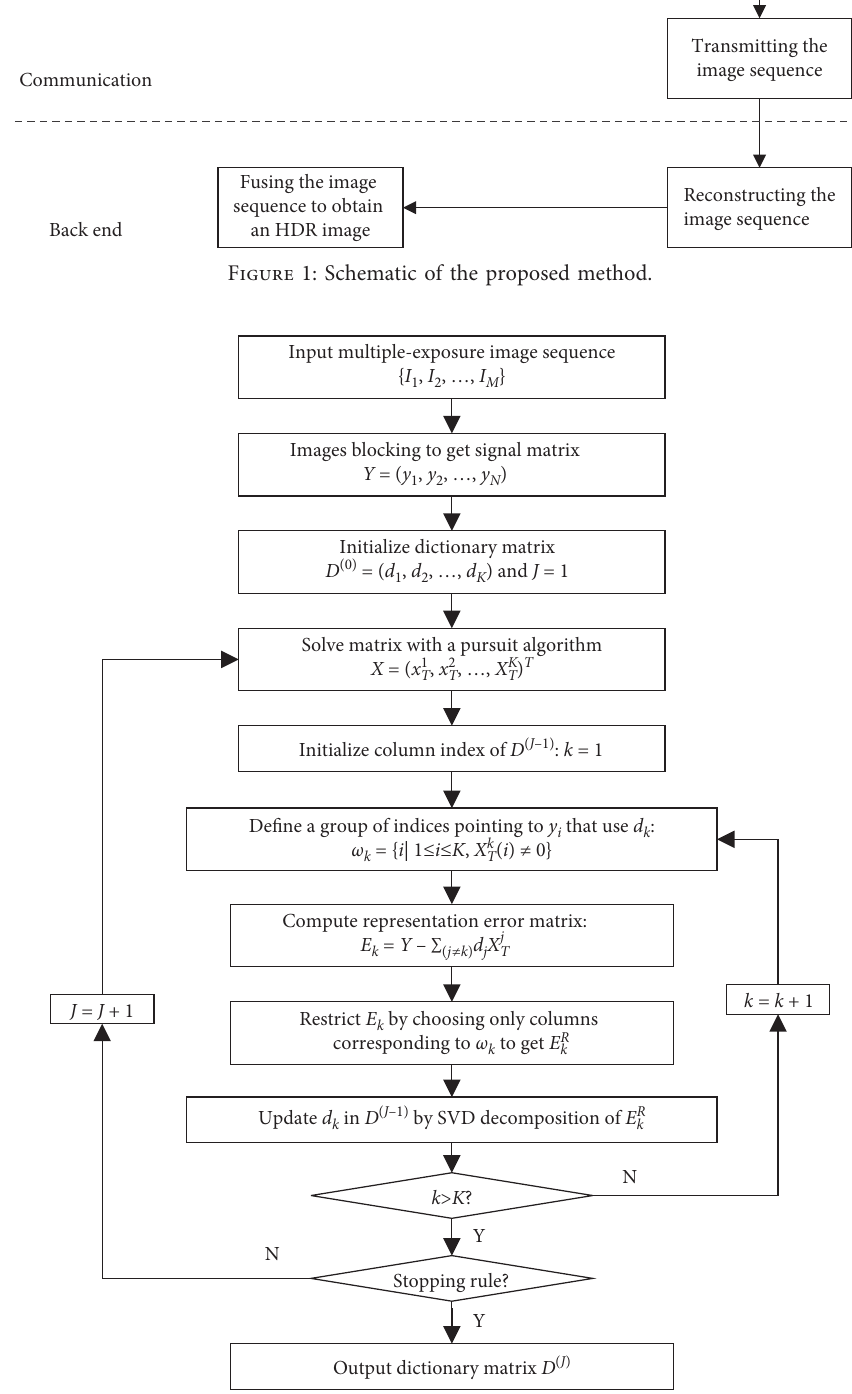
Figure 2: The flowchart of the K-SVD algorithm: I � 1 , 2 , ... , (M), is an image in image sequence. All images in image sequence are m , (m) divided into blocks and pixels in each block are rearranged into a column vector y i , i � 1, 2, ... , N . (N) is the number of vectors generated from the image sequence and (n) is the length of y i . Y ∈ R n × N is a matrix of column vectors y i . The dictionary D ( J ) ∈ R n × K is made up of atom vector d k , where K is the total number of atoms in D (J) and the superscript (J) is the number of iterations. X ∈ R K × N is the sparse representation of (Y) under dictionary (D) and is made up of row vectors x i T , i � 1 , 2 , ... , K , where the subscript Tof x i T indicates that x i T is a row vector and superscript Tindicates matrix transpose. The matrix E k is the error for all the input signal when the (k)th atom is removed. The detail of E R k and SVD decomposition of E R k can be found in